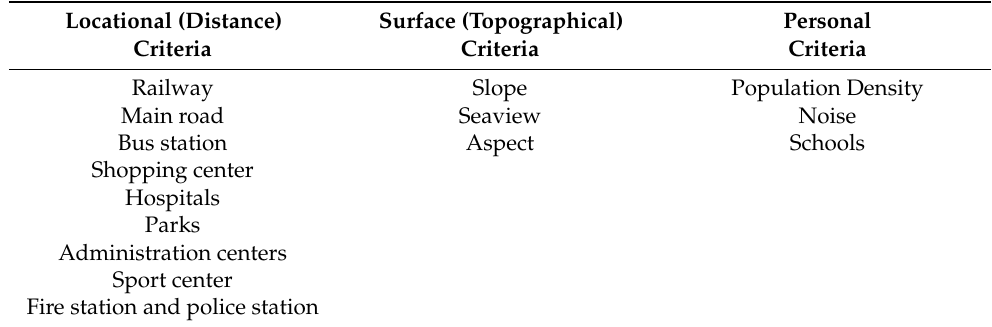
Table 2. Selected criteria for this